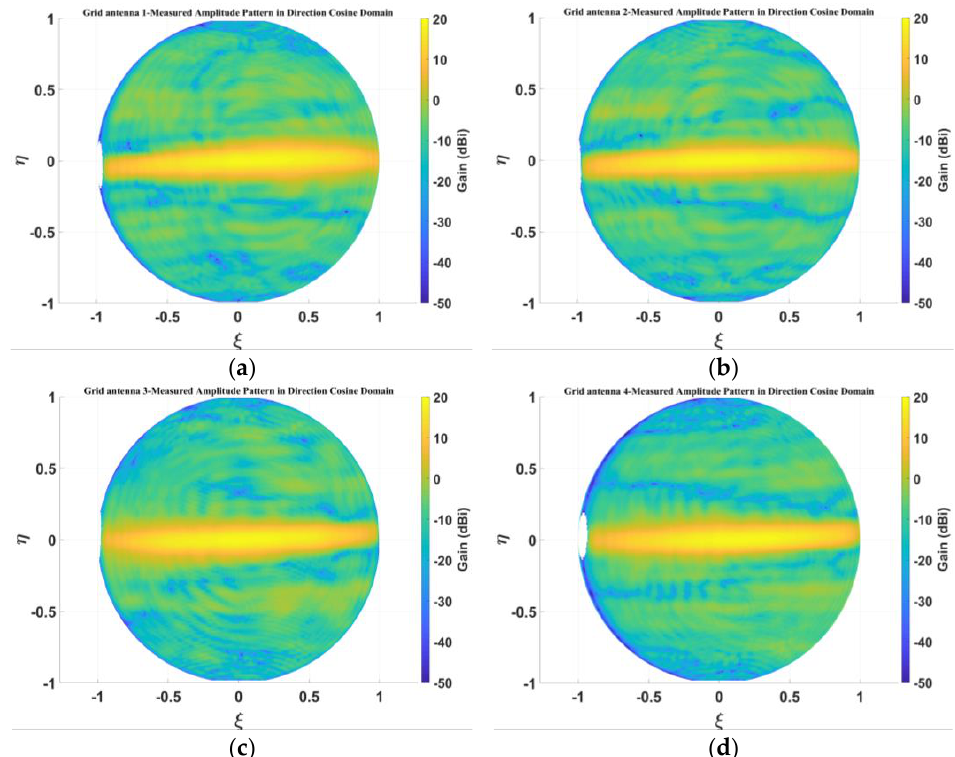
Figure 19. Measured amplitude pattern in direction cosine domain: ( a ) grid antenna 1; ( b ) grid antenna 2; ( c ) grid antenna 3; ( d ) grid antenna 4.